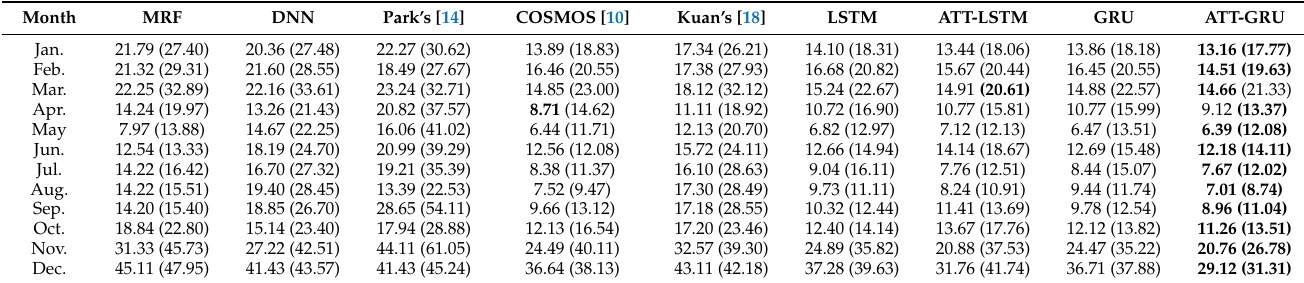
Table 7. MAPE (CVRMSE) comparison by months for Building 1.